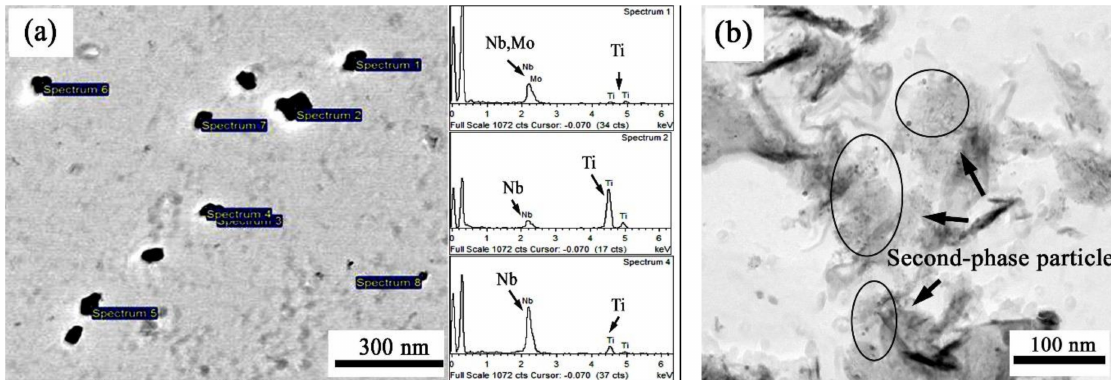
Figure 7. Precipitate phase of base material of Ti-Nb microalloyed